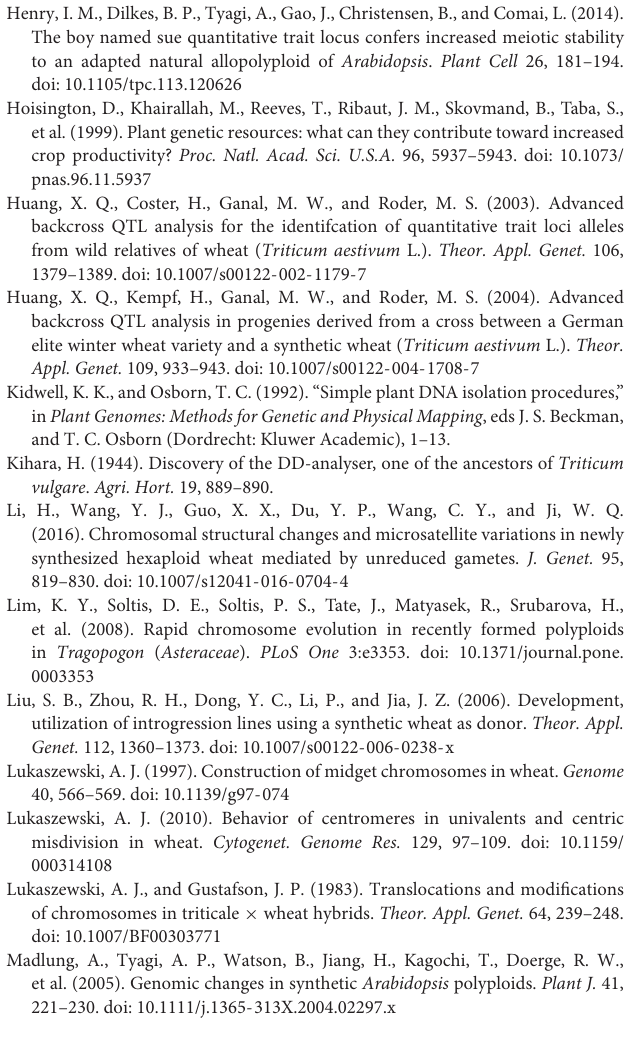
Supplementary Figure 1 | FISH karyotypes: (A) SHW-L1/Chuanmai 32 F 1 hybrid; (B) Chuanmai 32/SHW-L1 F 1 hybrid. Green FISH signals came from probe oligo-pTa-535; red signals were from probe oligo-pSc119.2. Supplementary Figure 2 | GISH and FISH karyotypes. (A) SHW-L1 and Chuanmai 32; (B) Two seedlings from two RILs with chromosome structural variations (white arrows). Supplementary Table 1 | Chromosome composition of progenies derived from selfed euploid SHW-L1 and SHW-L1/Chuanmai 32 F 1 . Supplementary Table 2 | Type and distribution of chromosomal structural variations. Supplementary Table 3 | Number of chromosomes having structural